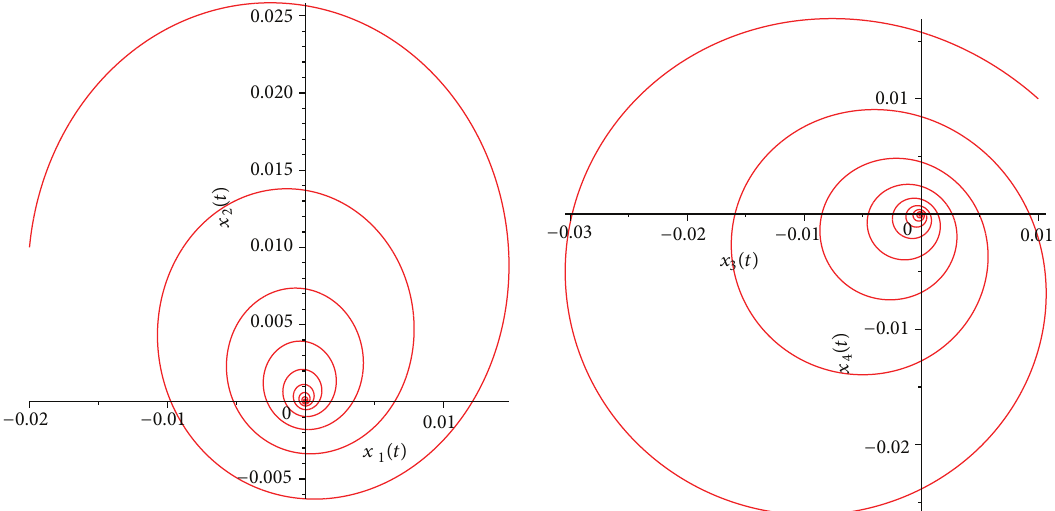
Figure 6: Trajectory projection starting from (𝑥 1 , 𝑥 2 ,𝑥 3 ,𝑥 4 ) = (−0.02, 0.01, 0.01, 0.01) converges to the E.S. when (𝛿 1 , 𝛿 2 ) = (−0.2,−0.2) .